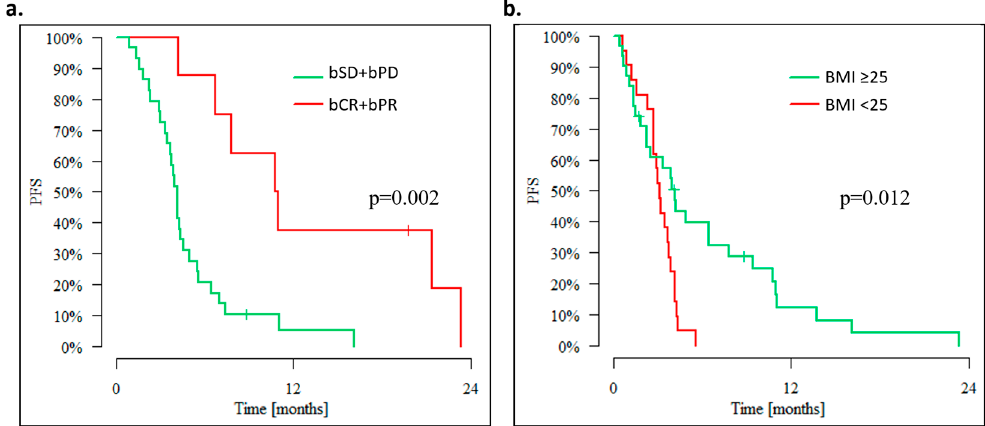
Figure 4. Progression-free survival according to ( a ) biochemical response, ( b ) BMI.